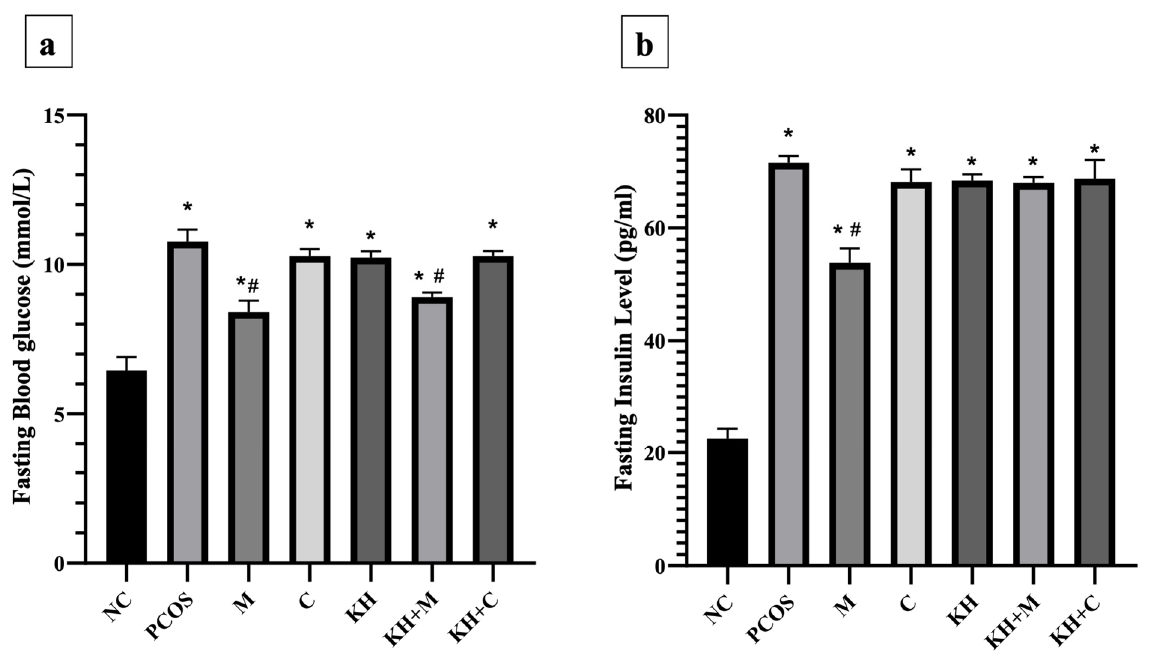
Figure 5. Effects of KH on the ( a ) fasting blood glucose and ( b ) insulin levels. NC: normal control; PCOS: Untreated PCOS; M: PCOS + Metformin; C: PCOS + Clomiphene; KH: PCOS + Kelulut honey; KH + M: PCOS + Kelulut honey + Metformin; KH + C: PCOS + Kelulut honey + Clomiphene. * p < 0.05 significance against the normal control group, # p < 0.05 significance against the untreated PCOS group. n = 6 per treatment group.